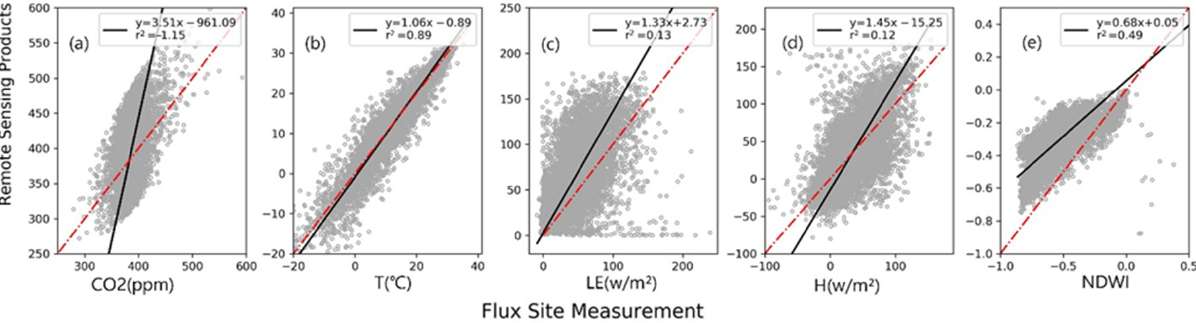
Figure A2. The comparison of remote sensing products data and ground EC-towers at site scale. The red dotted line is the 1:1 dotted line. Where ( a ) is CO 2 (ppm), ( b ) is T ( ◦ C), ( c ) is LE (w/m 2 ), ( d ) is H (w/m 2 ), and ( e ) is NDWI. It’s worth noting that the NDWI data is based on a spatial NDWI (500 m resolution) and spatial NDWI (10 km resolution) of different spatial resolutions.